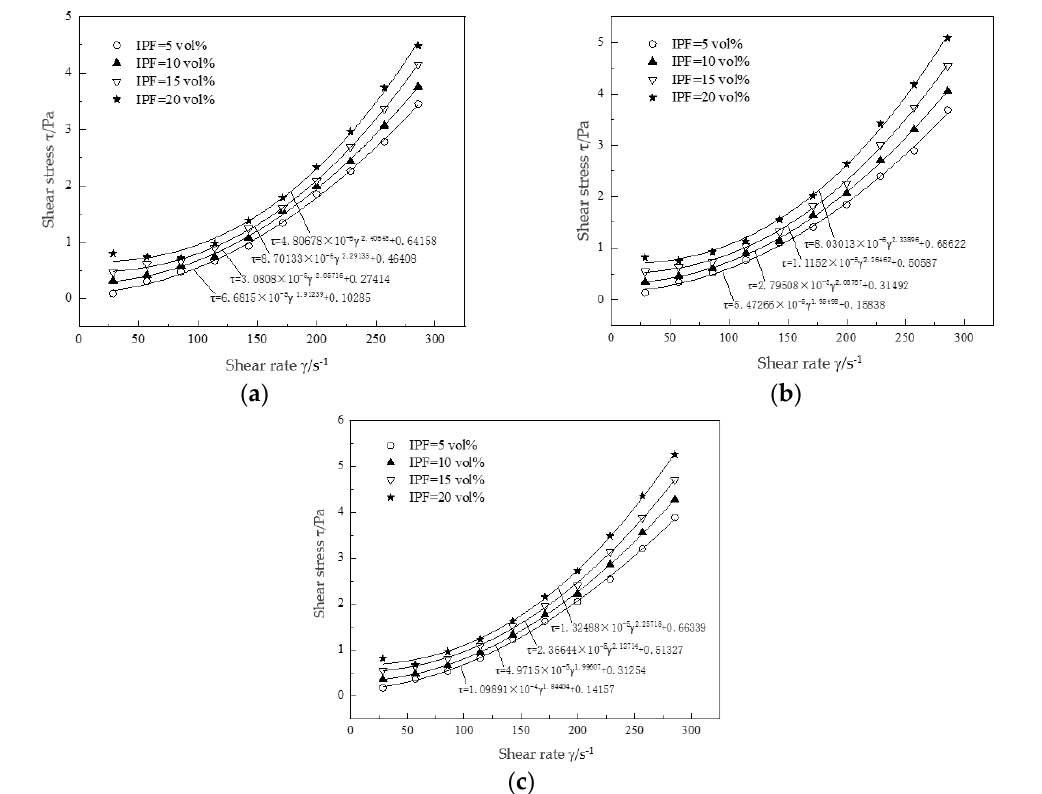
Figure 5. H–B model fitting curve under various working conditions when the pipe diameter was 28 mm: ( a ) particle size = 0.3 mm; ( b ) particle size = 0.4 mm; and ( c ) particle size = 0.5 mm.